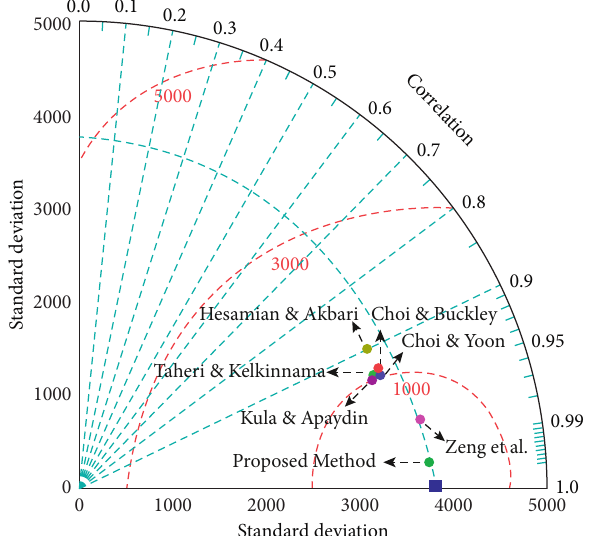
Figure 15: Comparison of performances of all models with Taylor’s diagram for the lower bounds in Example 9. The rectangle on the x -axis represents the observations, and the red-dashed contours indicate the centered Root Mean Square